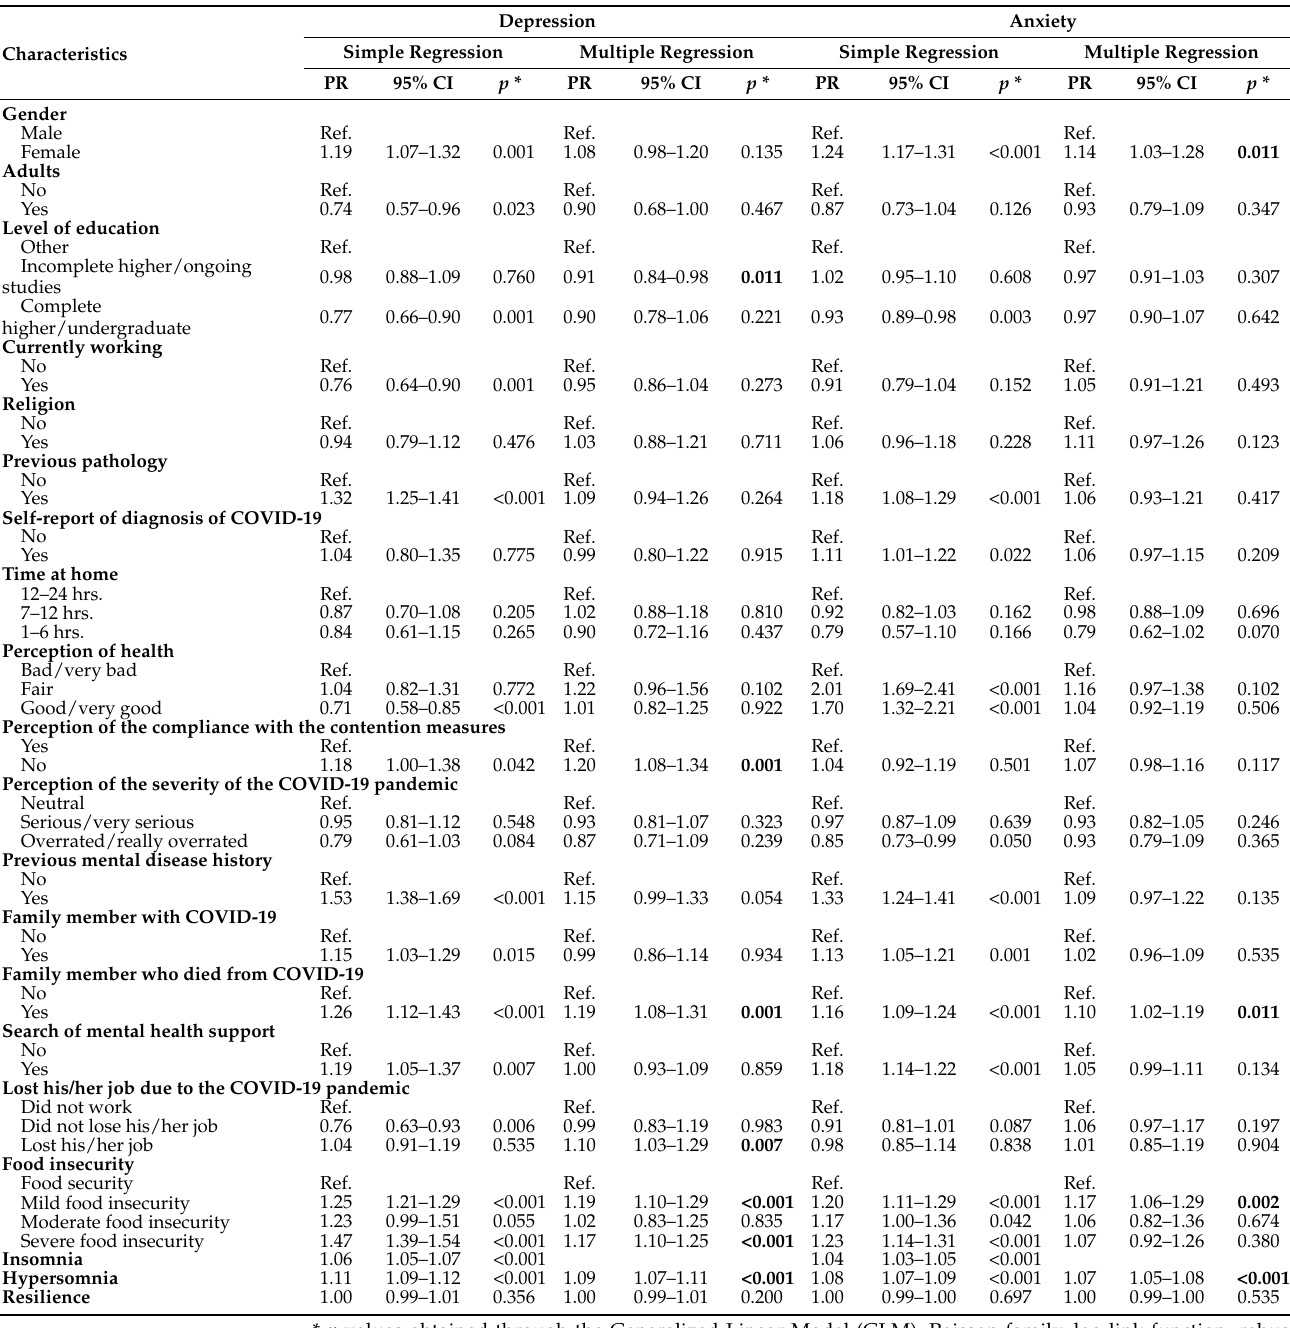
Table 4. Resilience and other factors associated with depression and anxiety in the simple and multiple regression